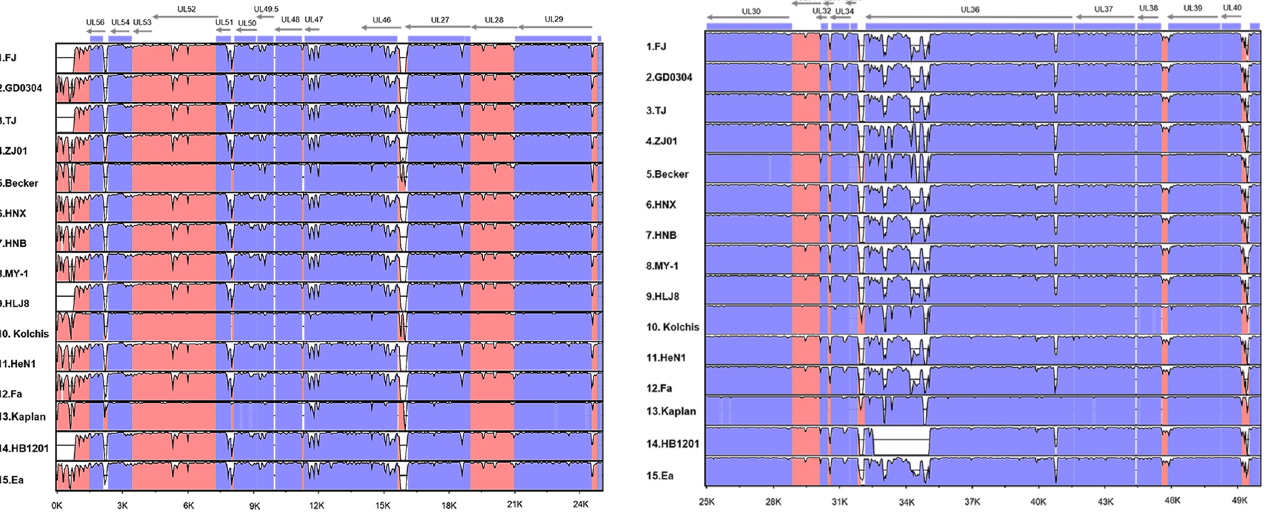
Table 4. Complete gene sequence nucleotide homology analysis.